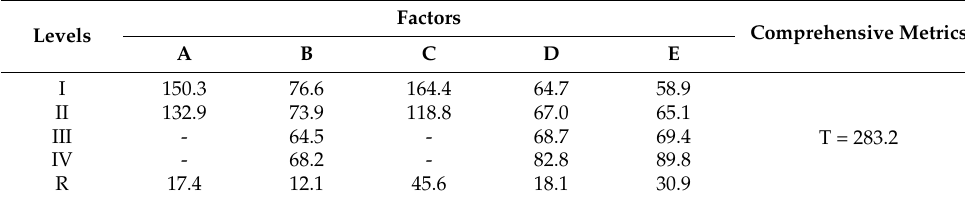
Table 5. Range analysis of the orthogonal experiment of paint film’s gloss GZL (%).